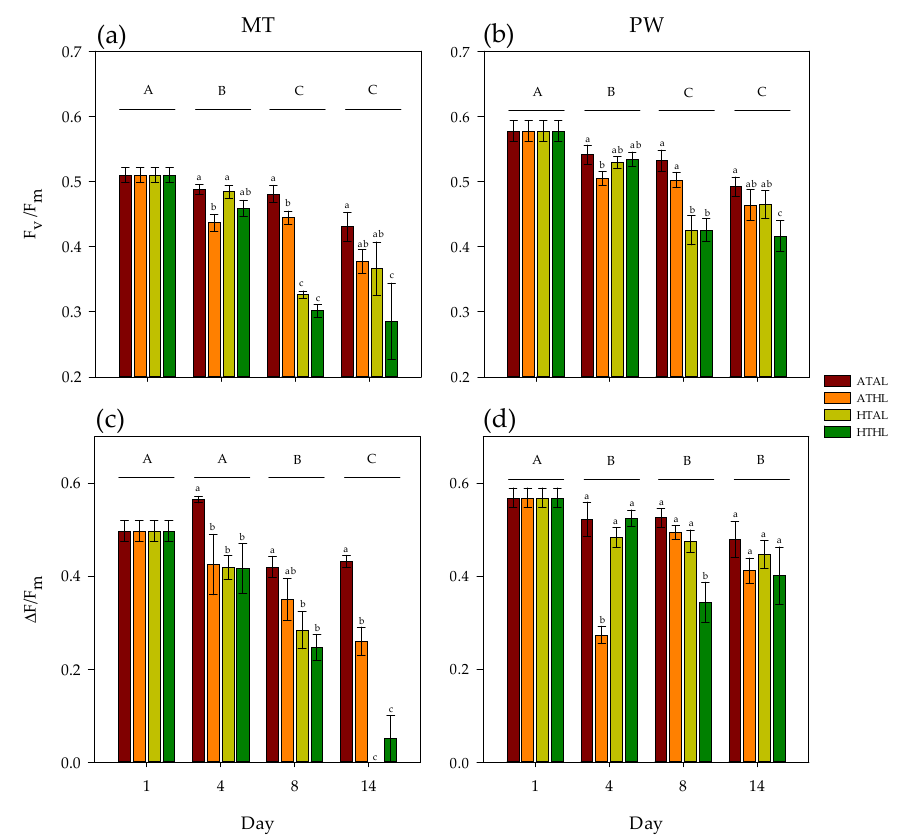
Figure 3. Maximum quantum yield (F v /F m ; a , b ) and effective quantum yield ( Δ F/F m ; c , d ) of P. acuta from MT and PW at each sampling time. Data are presented as mean ± SE (n = 4). A, B, C, D and a, b, c, d indicate significant differences by time and by treatment, respectively. Table 2. Statistical indices of maximum quantum yield (F v /F m ), photosynthetic efficiency ( ∆ F/F m ), RLC-derived parameters (alpha, rETR max , and I k ), cell density, and pigment contents (Chl a and Chl c 2 ) (four-way ANOVA).